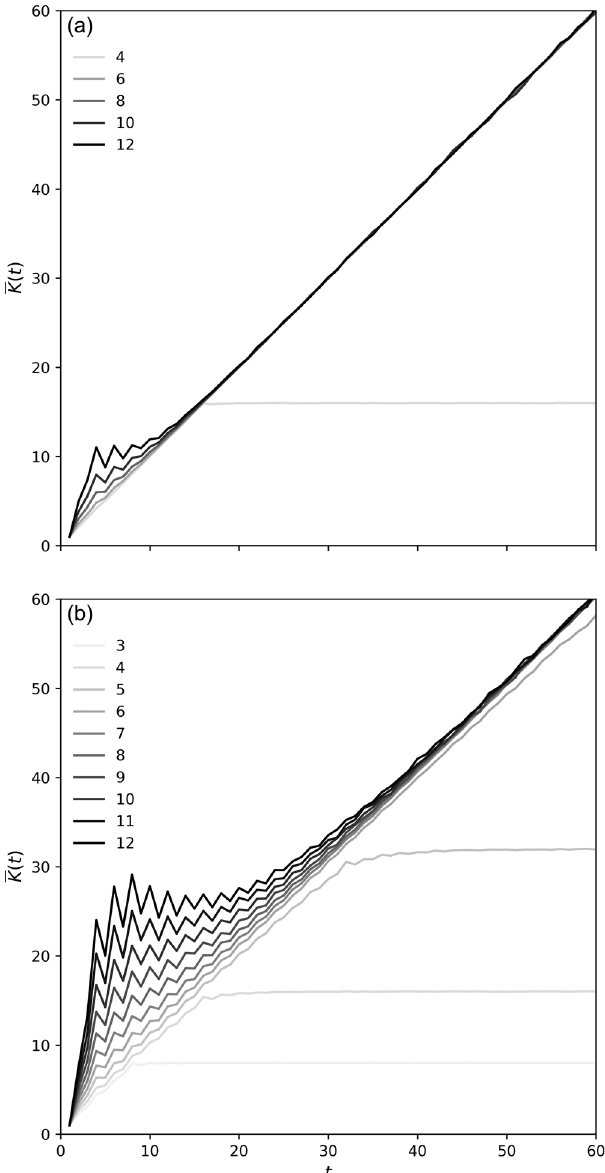
¯ K ð t Þ FIG. 5. Average SFF in the q ¼ 2 brickwork model with (a) periodic and (b) open boundary conditions. The system size 3 ≤ L ≤ 12 is shown on the legend, where L is necessarily even with periodic boundary conditions. In the diagonal regime ¯ K ð t Þ ¼ t ¼ q L , we have , and beyond the Heisenberg time t H ¯ K ð t Þ ¼ q L